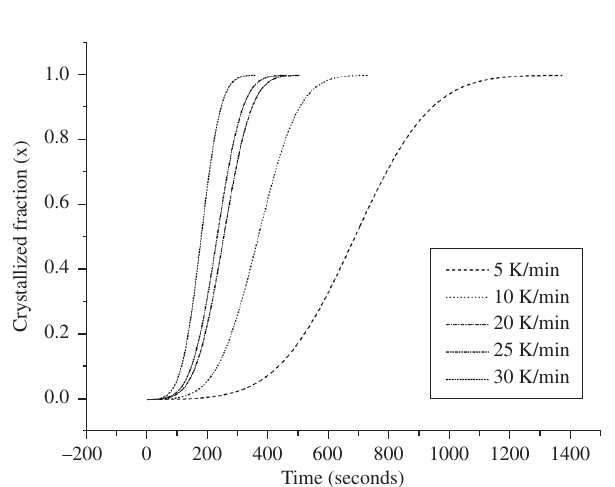
Figure 4. Crystallization fraction (x) for α -BZN crystallization at 5, 10, 20, 25, 30 K/min, under air